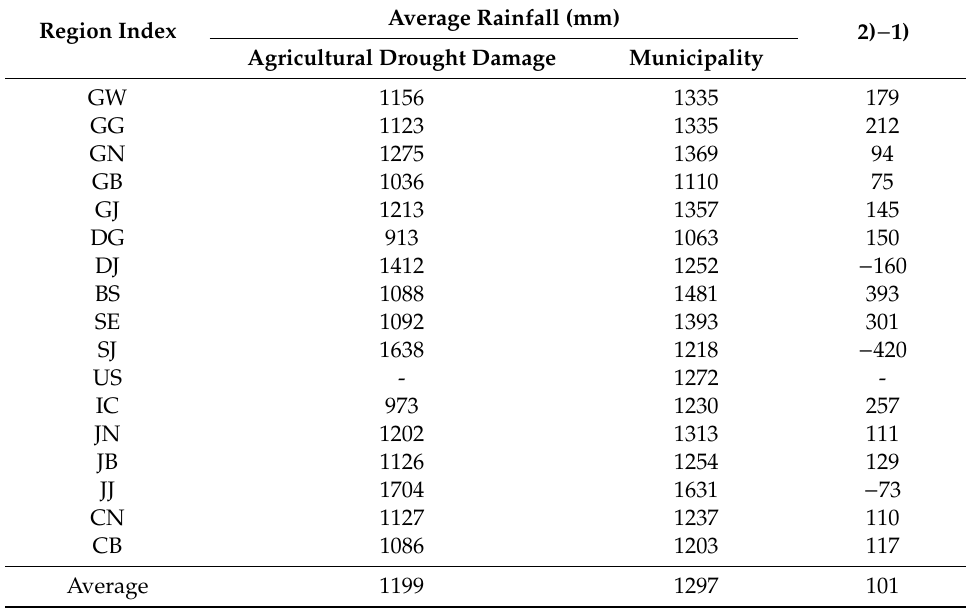
Table 4. Analysis of disaster-prevention rainfall of